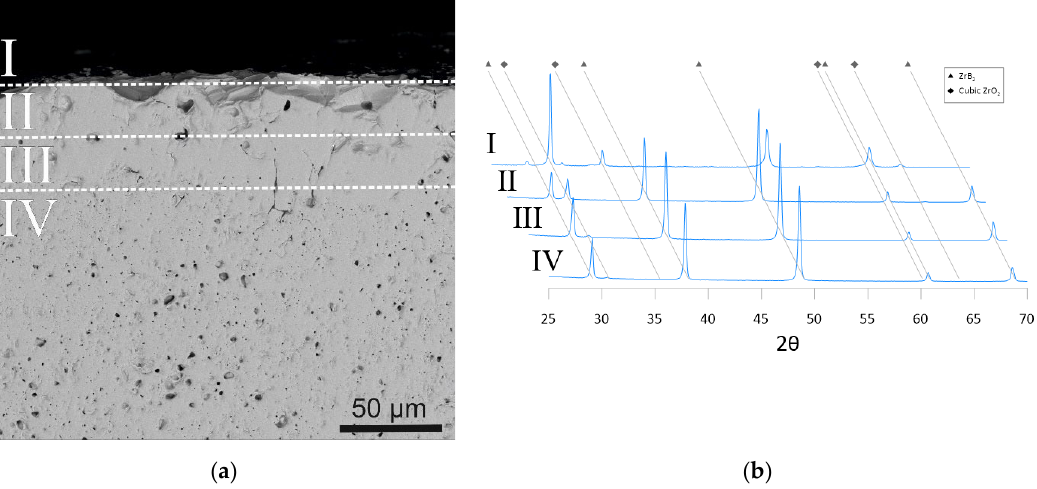
Figure 4. Change in the phase composition at the interface between the ZrO 2 coating and ZrB 2 –SiC substrate: ( a ) SEM image of the studied ceramic sample with an indication of the zones where the surface XRD patterns were obtained; ( b ) XRD patterns of subsurface layers showing changes in the phase composition.